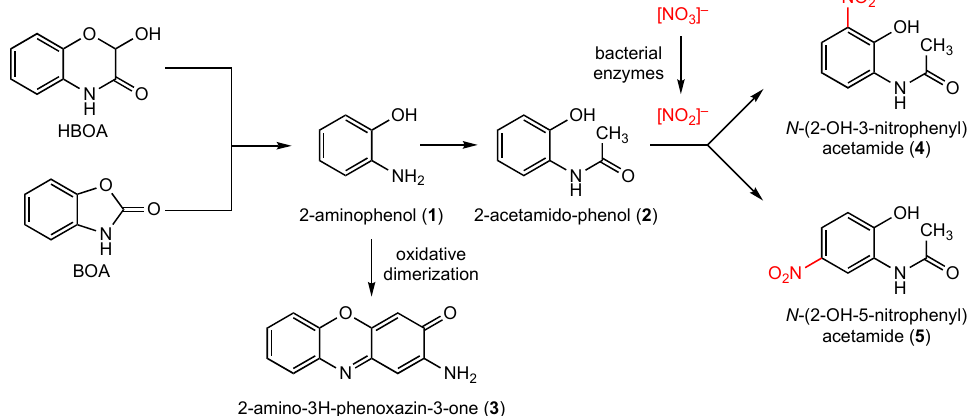
Figure 1. Microbial degradation of benzoxazolin-2( 3H )-one (BOA) and the benzoxazolinone derivative HBOA. The degradation product 2-aminophenol ( 1 ) is converted to 2-acetamidophenol ( 2 ), the substrate for microbial nitration at position 3 and 5. In another route, 1 is oxidatively dimerized to 2-amino-3H-phenoxazin-3-one ( 3 ), a substrate for numerous substitution reactions by microorganisms [3,4].